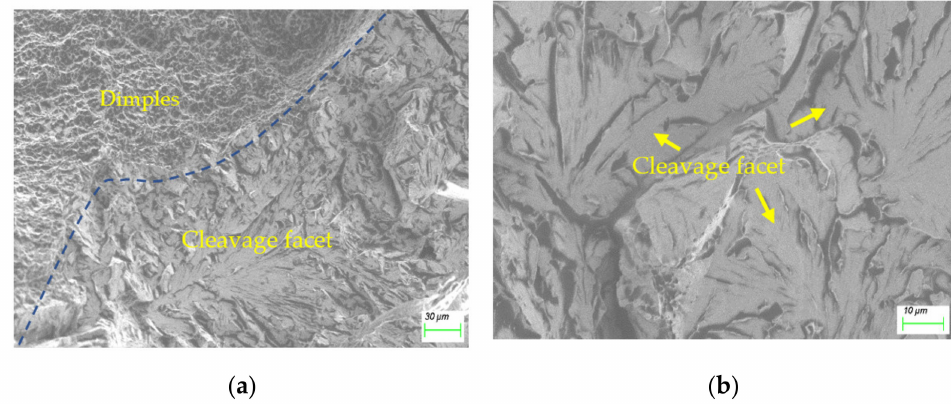
Figure 6. Fractography of: ( a ) fusion plane; ( b ) magnified MA.